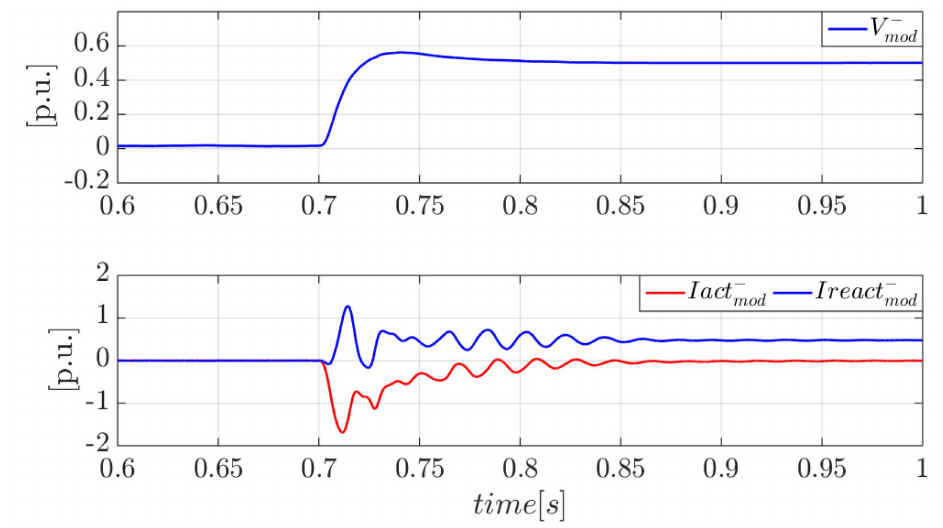
Figure 24. GFM converter negative sequence voltage and currents during an unbalanced fault with 0.5 p.u. depth.